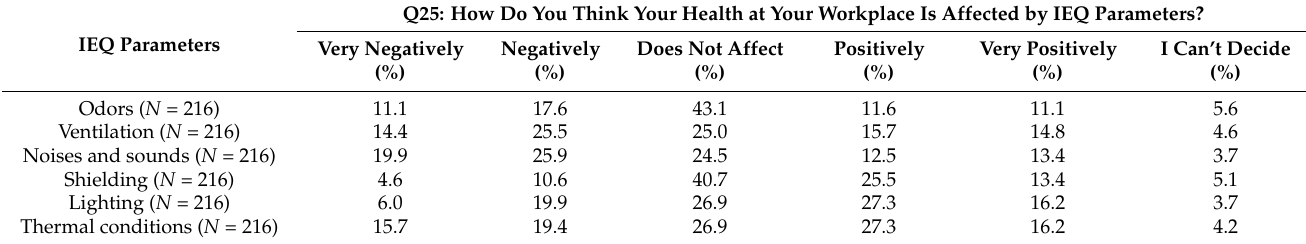
Table 3. Occupants’ self-perceived sensation of health related to IEQ parameters in the work environment.